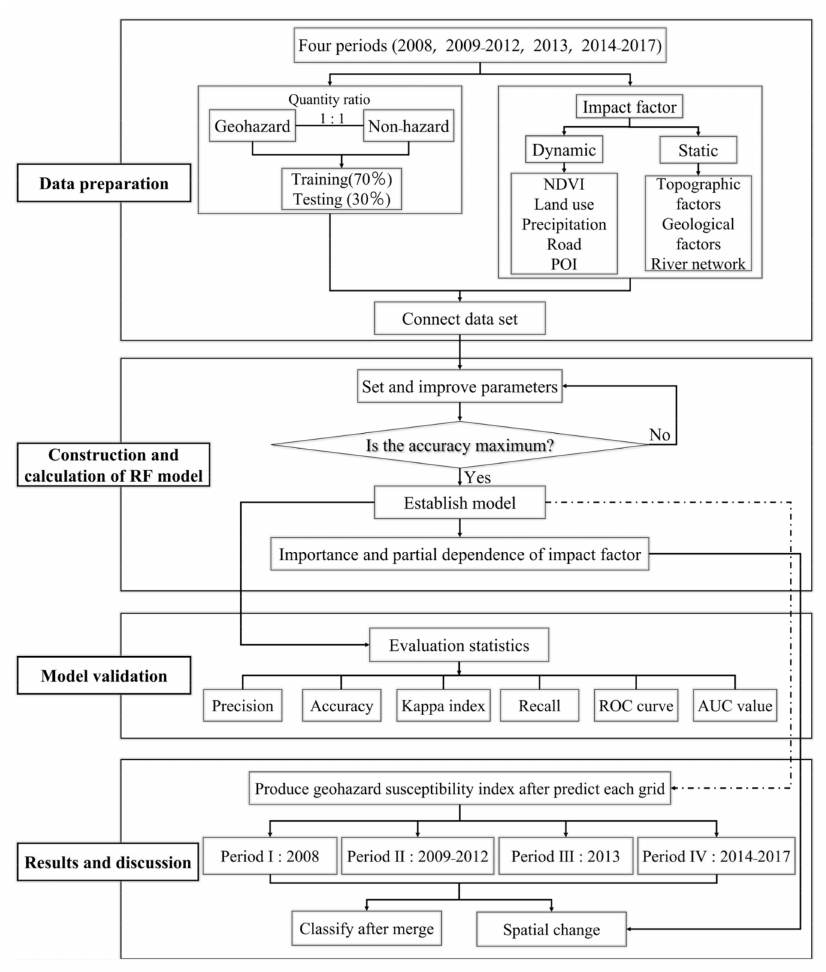
Figure 4. Study flow